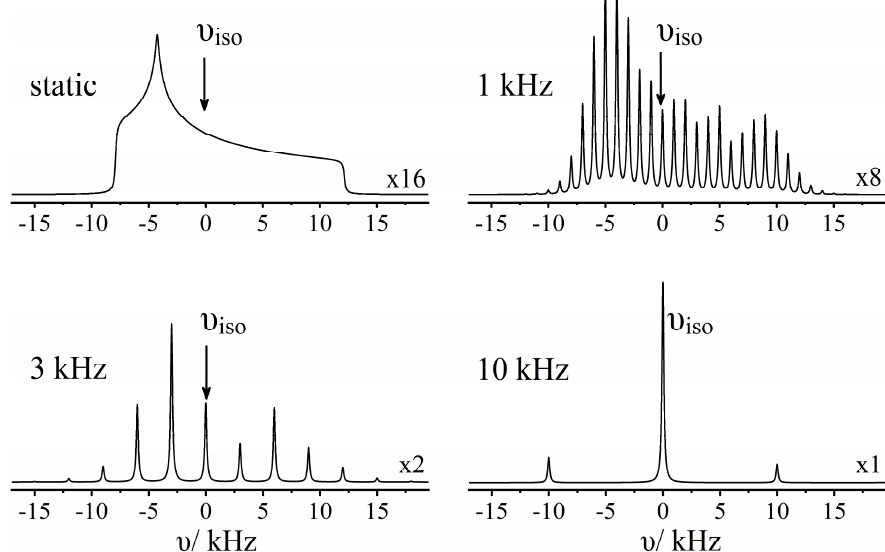
Figure 3. Numerical simulations demonstrating the effect of magic-angle spinning (MAS) upon the solid-state NMR line shape of a spin-1/2 nucleus with dominant line broadening due to the magnetic shielding anisotropy. Spinning sidebands are located at integer multiples of the rotor frequency.